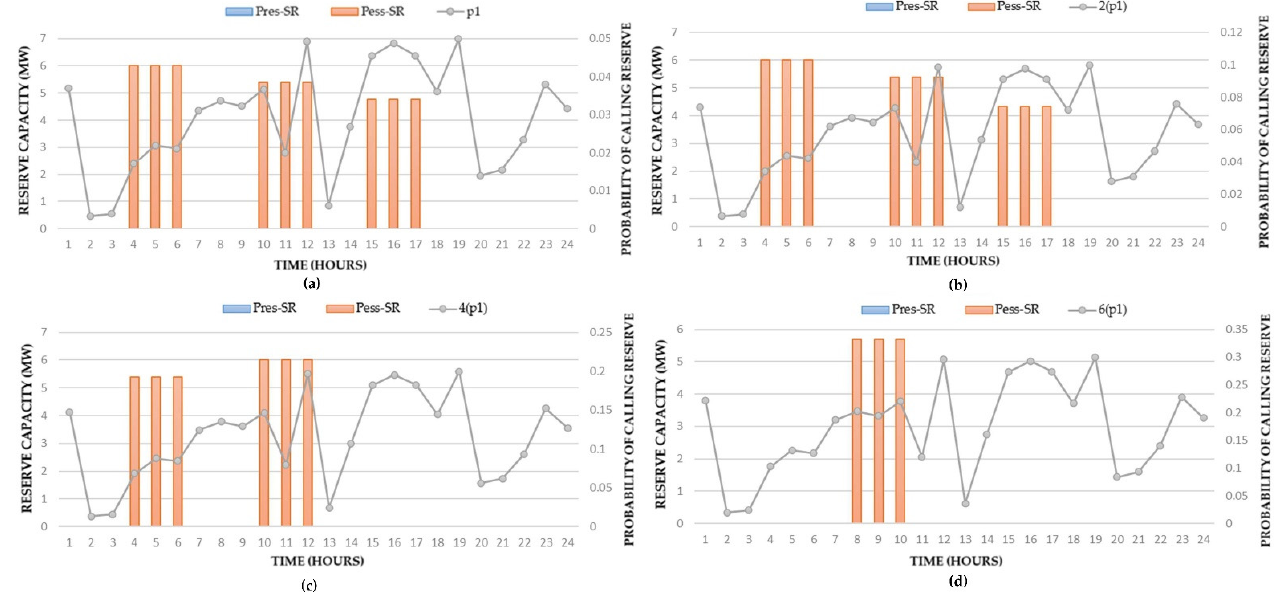
Figure 11. The VPP’s reserve bidding with reserve probability ( a ) p 1 , ( b ) 2 p 1 , ( c ) 4 p 1 , ( d ) 6 p 1